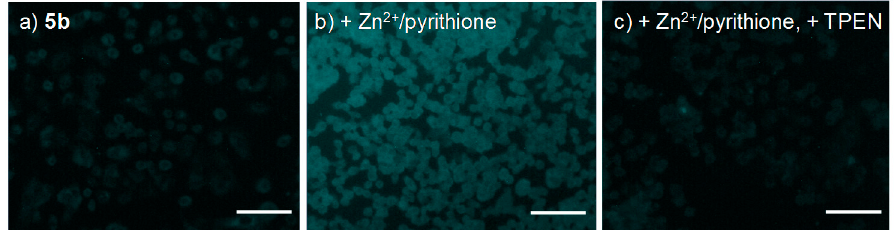
Figure 6. Fluorescence images of exogenously added Zn 2+ in A549 cells: ( a ) Fluorescence image of cells with 5b (100 μ M); ( b ) fluorescence image incubated with 5b (100 μ M) in the presence of Zn 2+ /pyrithione (100 μ M); ( c ) fluorescence image of ( b ) after treatment with TPEN (100 μ M). Scale bars = 300 μ m.